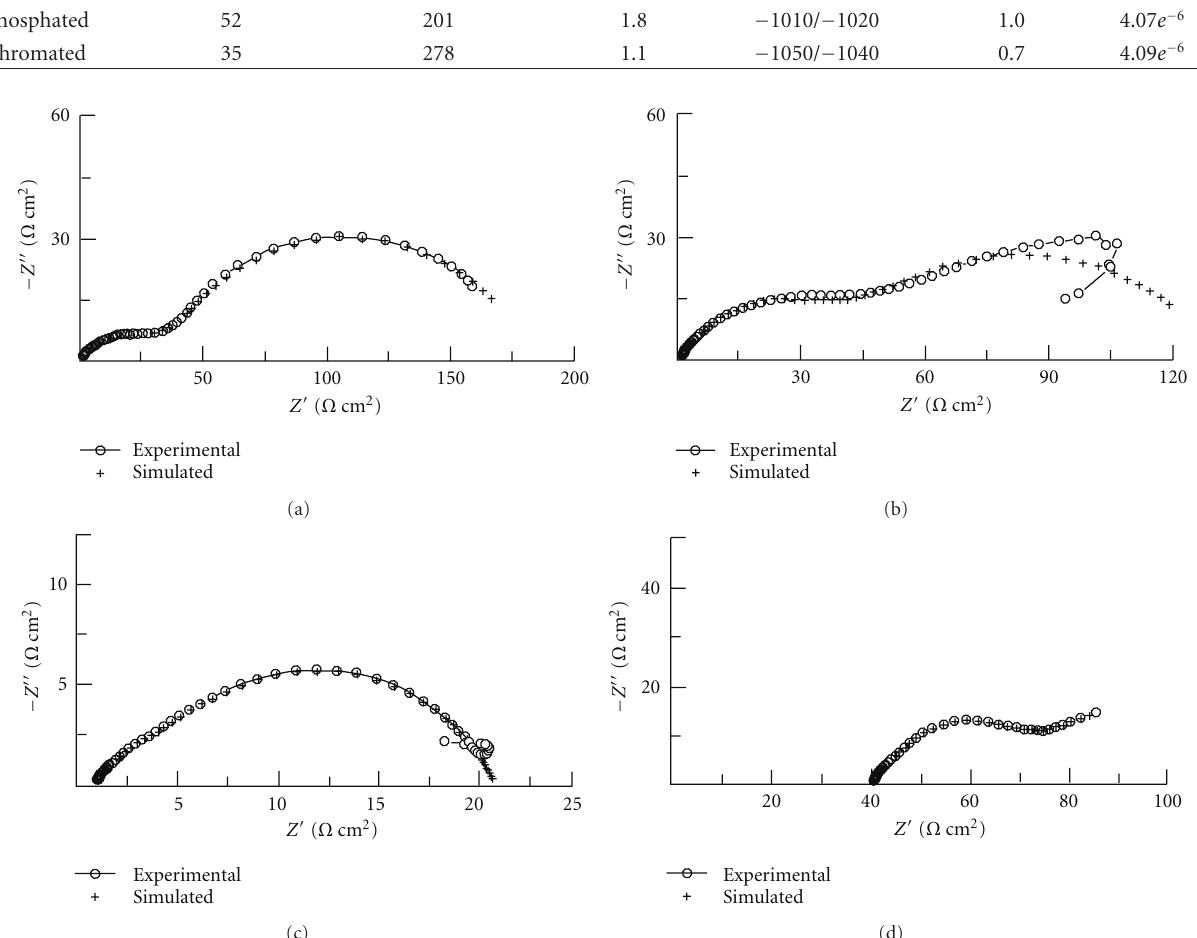
Figure 6: Experimental and simulated Nyquist impedance diagrams of galvanized steel with various surface treatments immersed in a 0.5 M NaCl solution during 1h (a) phosphated, (b) chromated, (c) untreated, and (d) untreated immersed during 168 h.